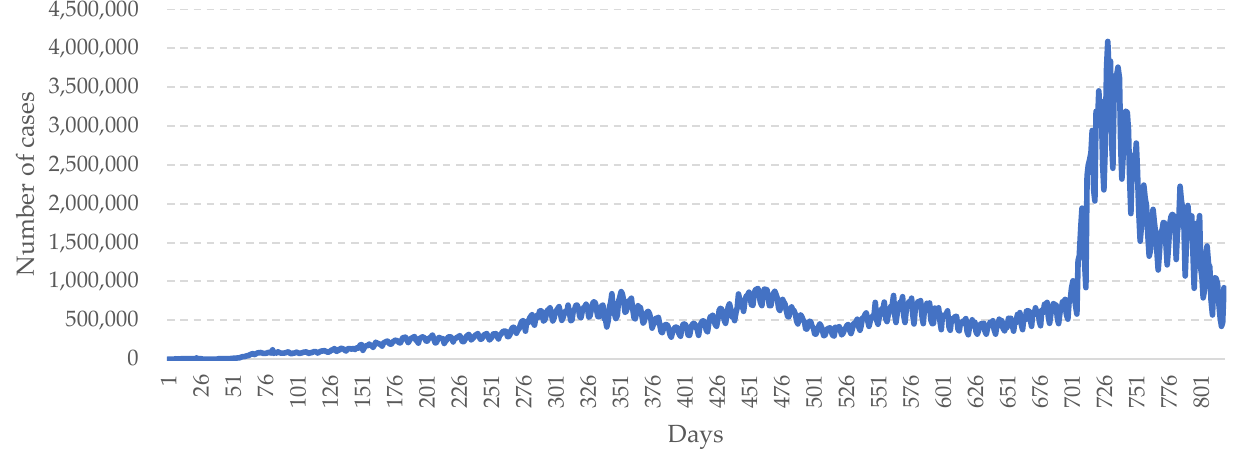
Figure 4. Daily new confirmed COVID-19 cases worldwide.